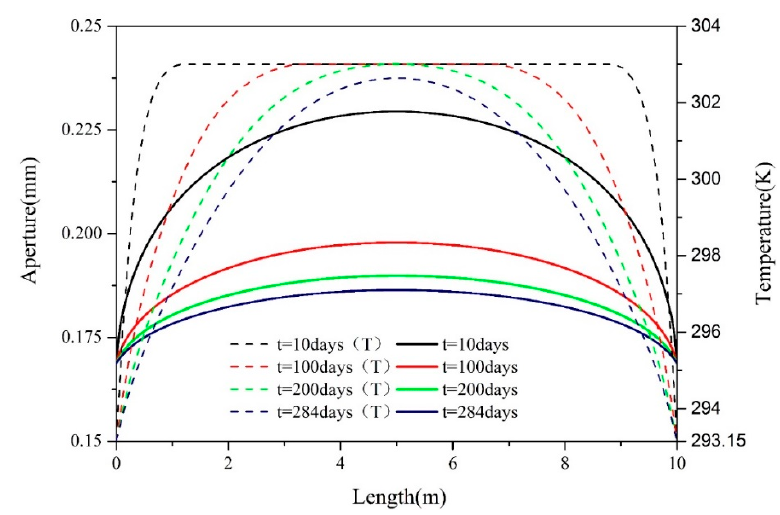
Figure 9. The evolution of hydraulic fracture aperture and temperature in hydraulic fracture at different times.